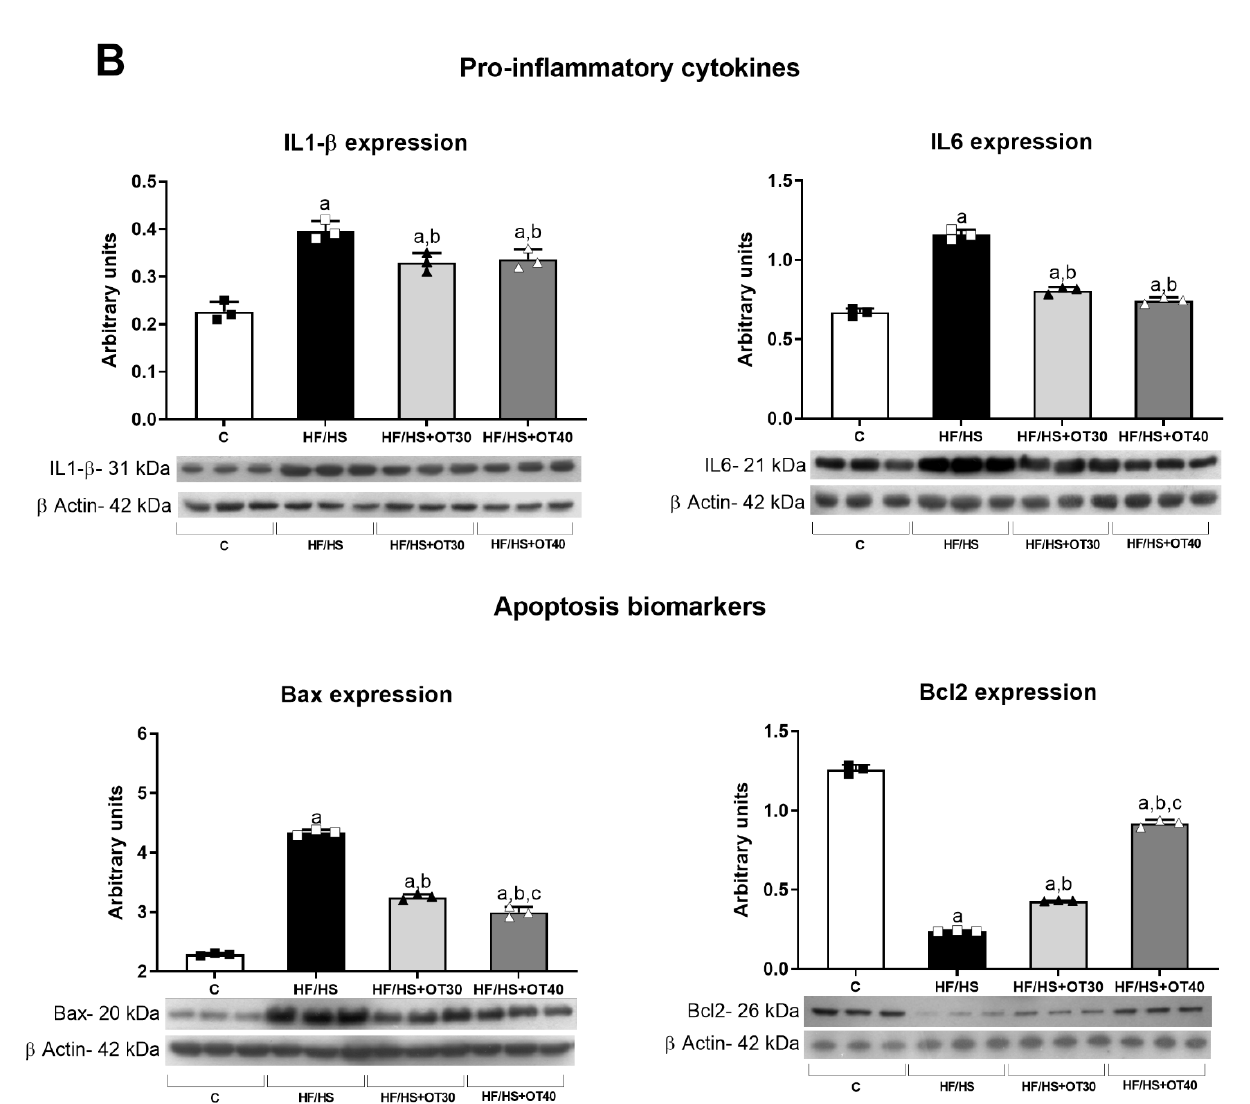
Figure 2. Effects of HF/HS diet and osthol administration on renal function and markers of renal damage. ( A ) Glomerular filtration rate (GFR), proteinuria, urinary nephrin excretion, N-acetyl- β -D-glucosaminidase (NAG) urine activity, urinary neutrophil gelatinase associated-lipocalin (NGAL) urinary excretion, and kidney injury molecule (KIM)-1 renal cortex expression. ( B ) Pro-inflammatory cytokine expression in the renal cortex (IL-1 β and IL-6) and apoptosis biomarker expression (BAX and Bcl2). For Western blotting, 3 randomly selected samples per group were analyzed. Results are presented as the mean ± SD and analyzed by one-way ANOVA. Post hoc analysis was performed using Bonferroni’s test. a: p < 0.05 vs. Control; b: p < 0.05 vs. HF/HS; c: p < 0.05 vs. HF/HS + OT30).